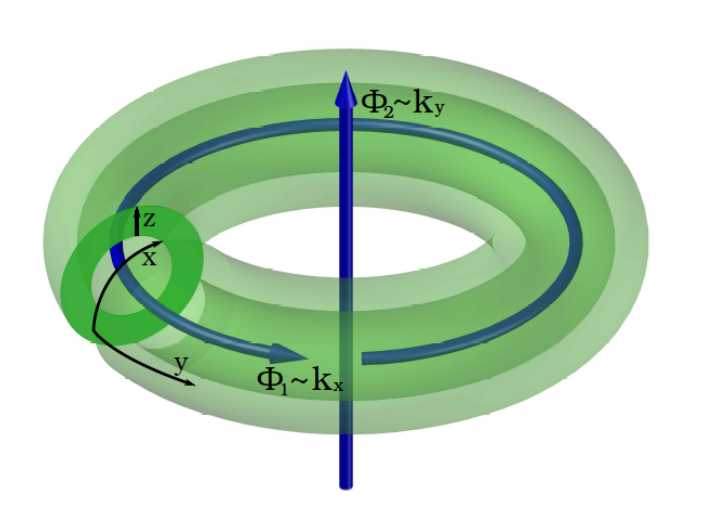
1 and (cid:8) 2 modi(cid:12)es the